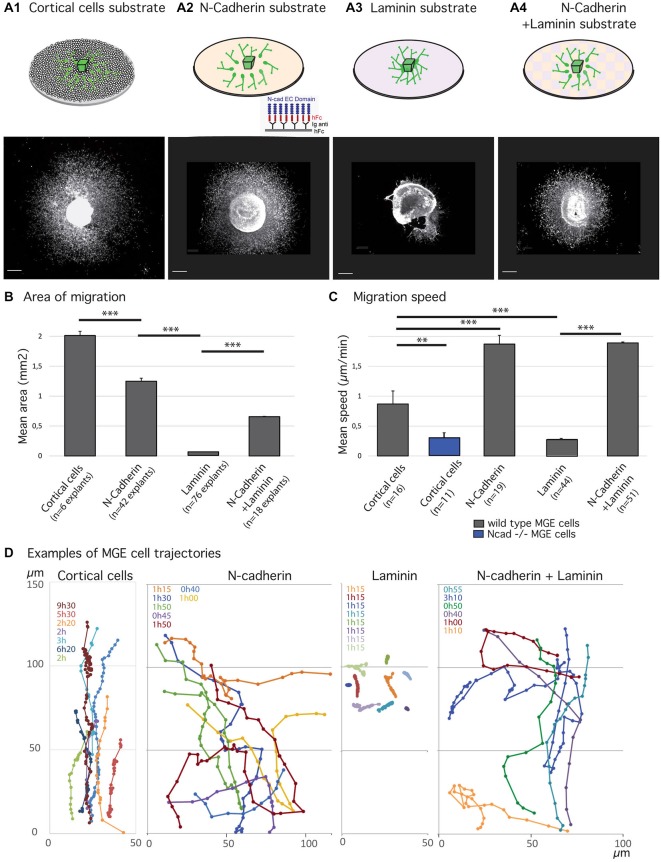
Migratory behavior of medial ganglionic eminence (MGE) cells on various substrates of migration. (A1–B) Analysis of migration in fixed preparations. Schemes (A1–A4) illustrate co-culture and culture models compared in the present study. Co-culture of MGE explants on dissociated cortical cells (A1) mimics the in vivo situation. Biomimetic substrates are prepared on glass coverslips with the extracellular domain of N-cadherin fused to a human Fc fragment, N-cad-Fc (A2, see “Materials and Methods” Section), or with laminin (A3), or with a mixture laminin/N-cad-Fc (A4, see “Materials and Methods” Section). Pictures below schemes illustrate the typical distribution of green fluorescent protein (GFP)-expressing MGE cells after 24 h of migration. Scale bars, 200 μm. Histogram in (B) gives the average area of migration covered by MGE cells around their explant of origin. The largest migration areas are observed on cortical cells (A1) and on N-cad-Fc substrate (A3). Values significantly different (**p < 0.01; ***p < 0.001). (C,D) Dynamic analysis of MGE cell migration using time-lapse videomicroscopy. Cells were imaged every 3 min for at least 30 min. Histogram (C) shows the mean instantaneous migration speed of the cell body of wild type (gray bars) and N-cadherin invalidated (blue) MGE cells on various substrates. Graphs in (D) are examples of cell trajectories at the front of the migration area (MGE explant up). Each cell track is shown in a specific color and the recording duration (hours, minutes) is indicated with the same color on the left upper corner. Dots indicate the position of the nucleus at each time point. MGE cells trajectories on dissociated cortical cells are rather straight and dots indicate the saltatory progression of the cell body. N-cad-Fc, alone or associated with laminin, strongly activates cell motility. On pure N-cadherin, MGE cells frequently turn or invert (green, yellow curves) their direction of migration. Cells movements on laminin are very slow. MGE cells are unbranched and form chains (see Figure 2A) in which cell bodies move alternatively forth and back. Trajectories are most often straight. On N-cadherin/laminin, trajectories are straighter than on N-cadherin (blue, orange curves).